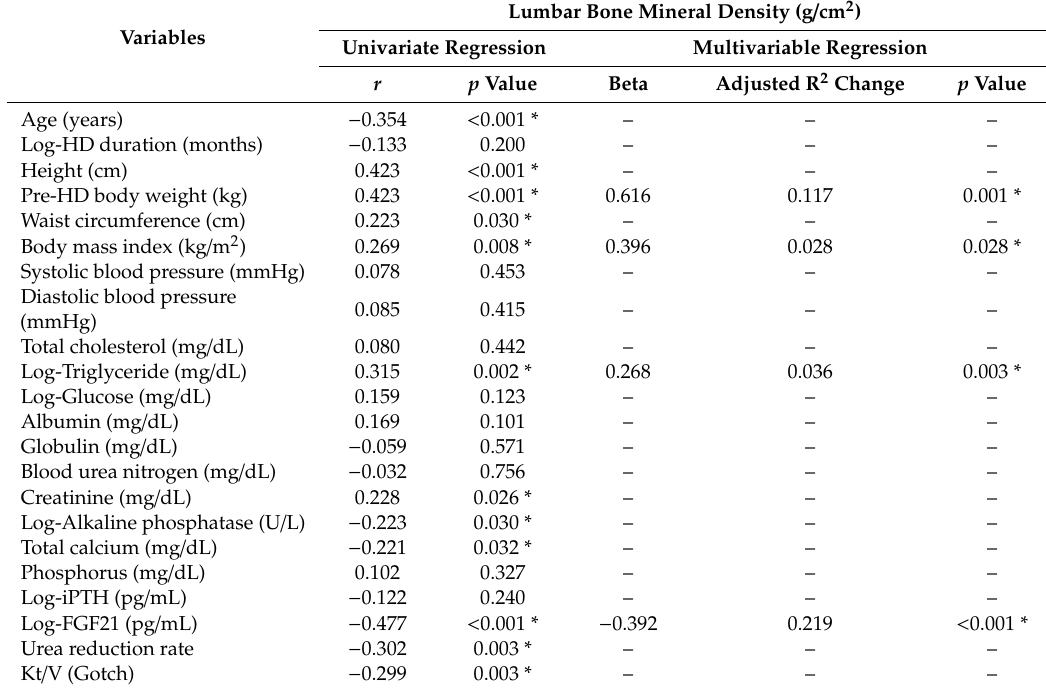
Table 3. Correlation of lumbar bone mineral density levels and clinical variables by simple regression or multivariable linear regression analyses among the 95 hemodialysis